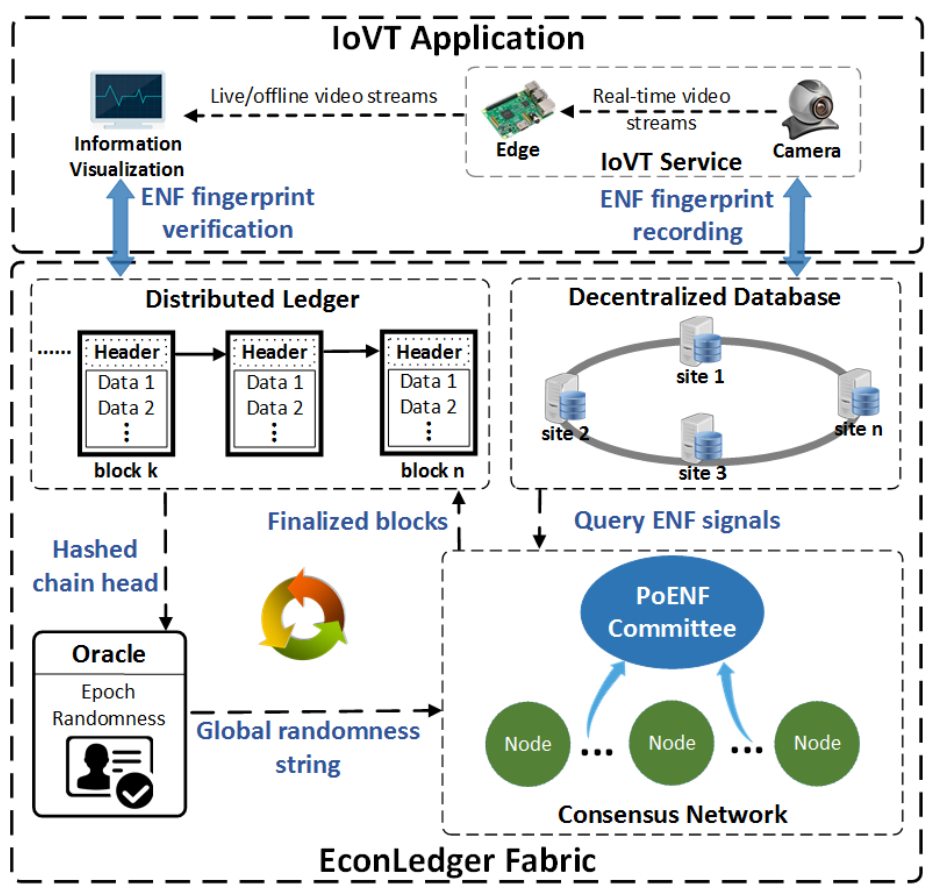
Figure 1. The EconLedger system